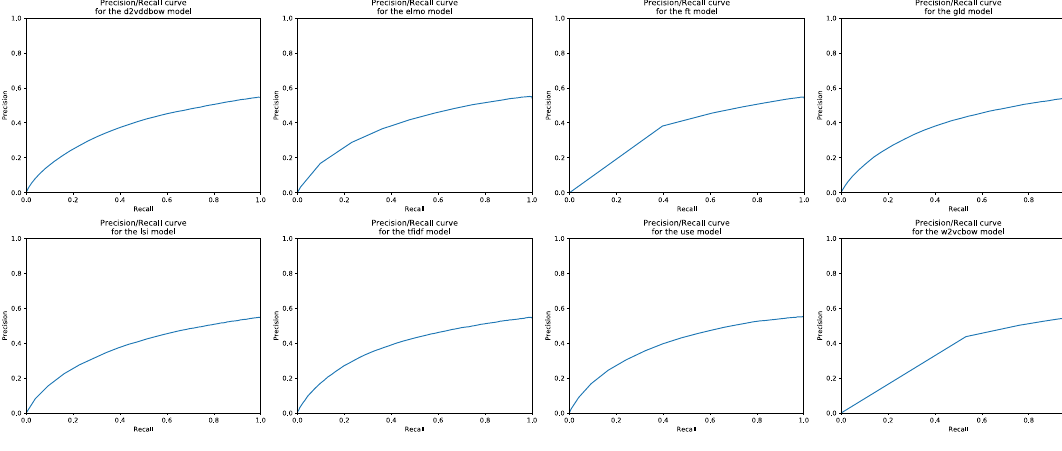
Figure A5. Precision/recall curves for eight models processing Webis corpus.